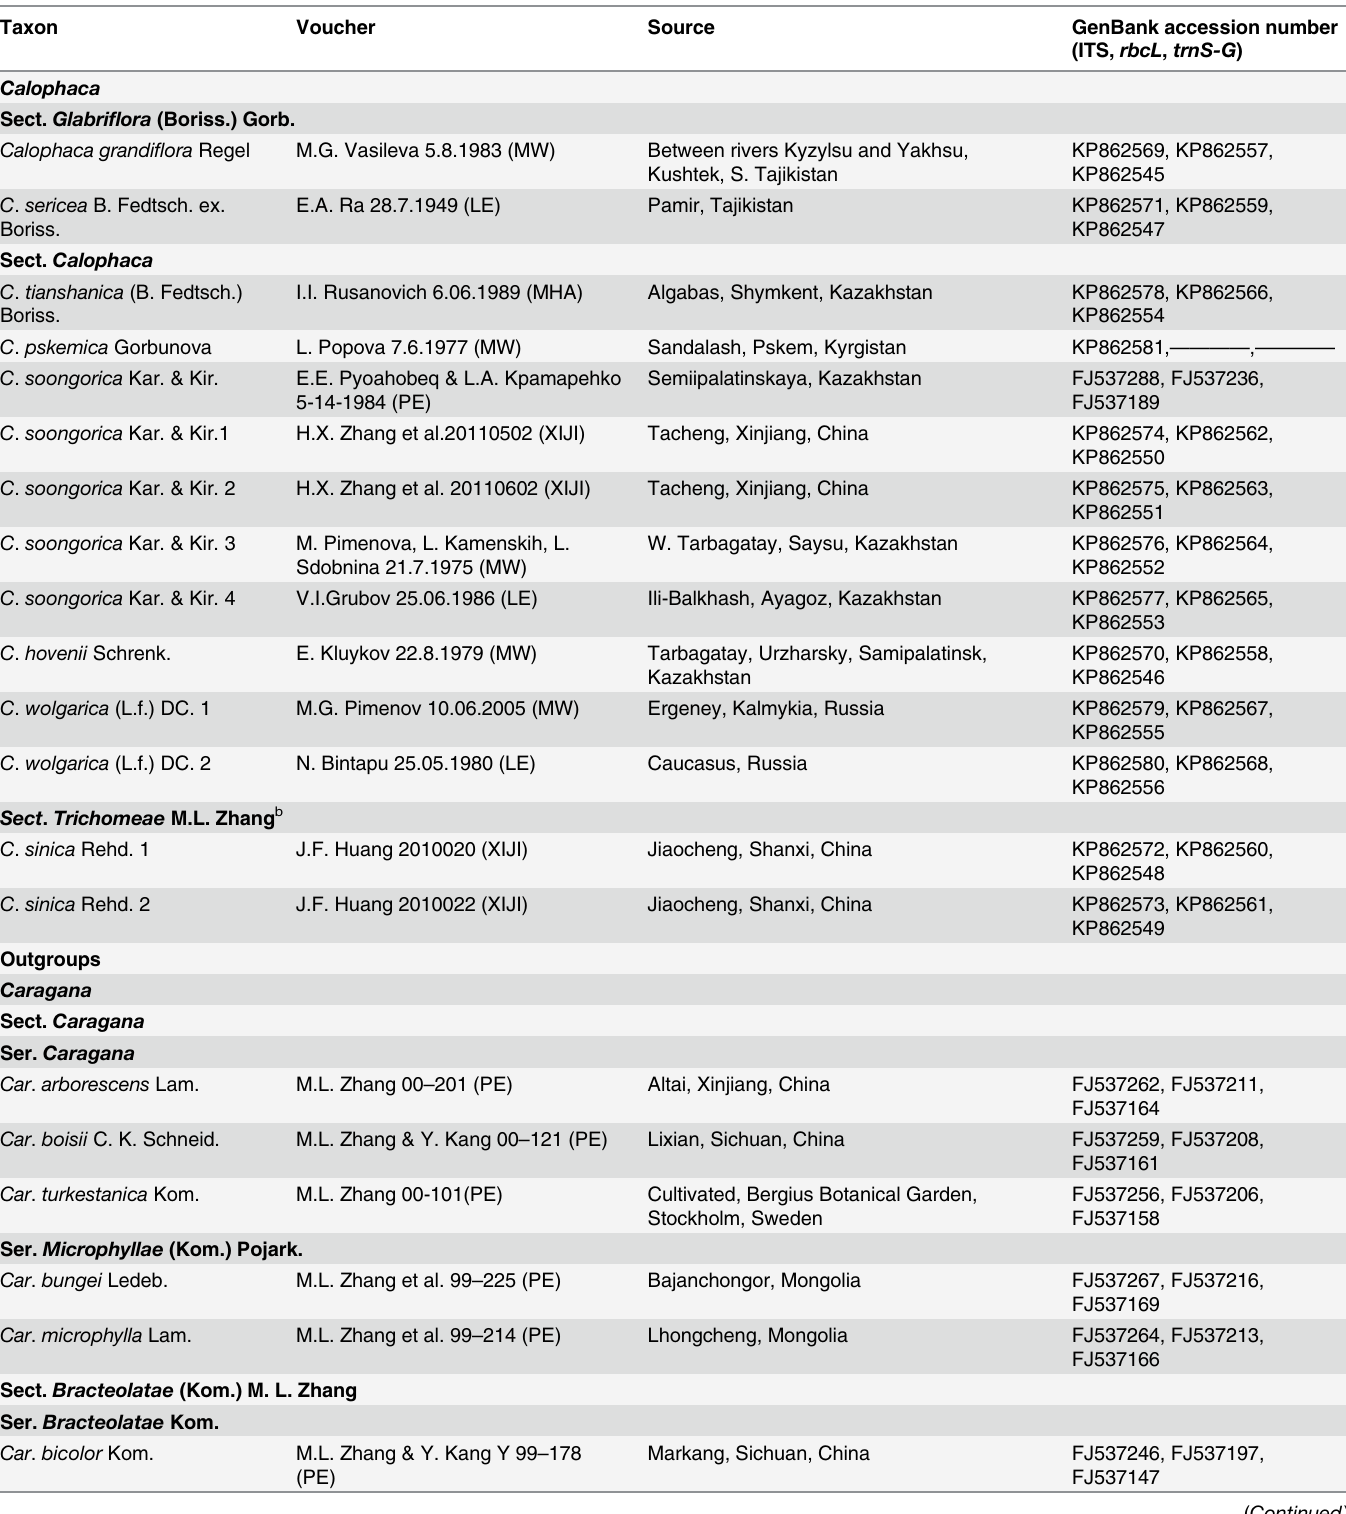
Table 1. Voucher information for Calophaca and four genera as the outgroups.